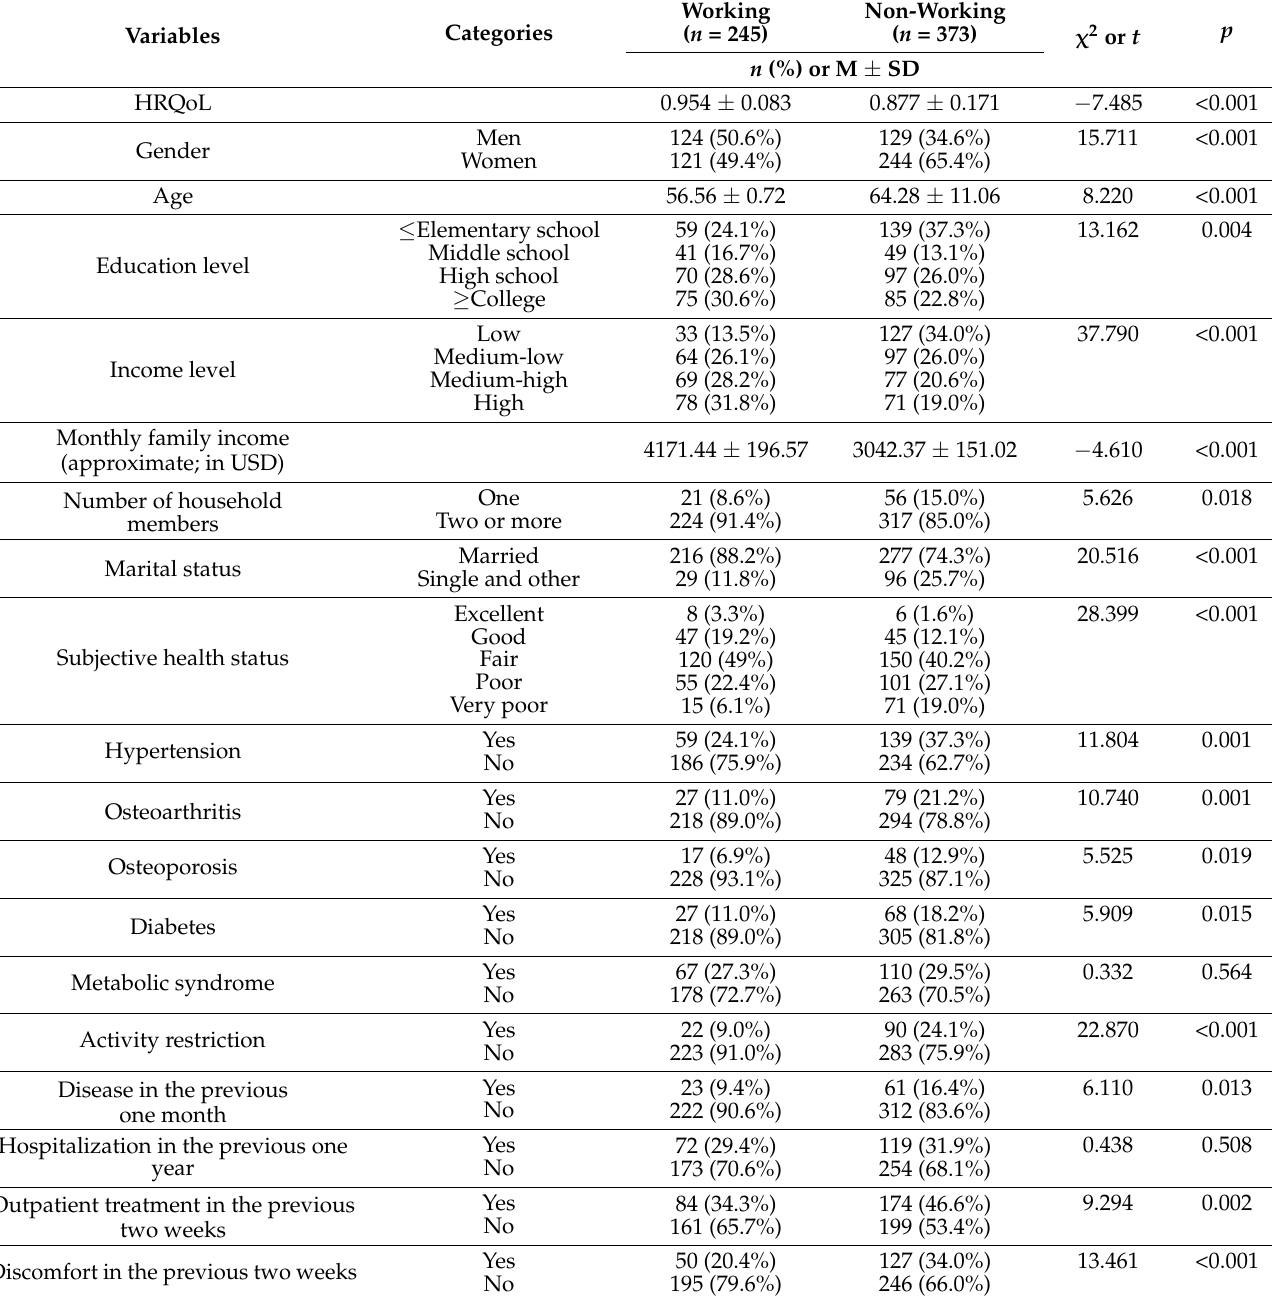
Table 1. General characteristics and health-related variables depending on the occupational status, n =